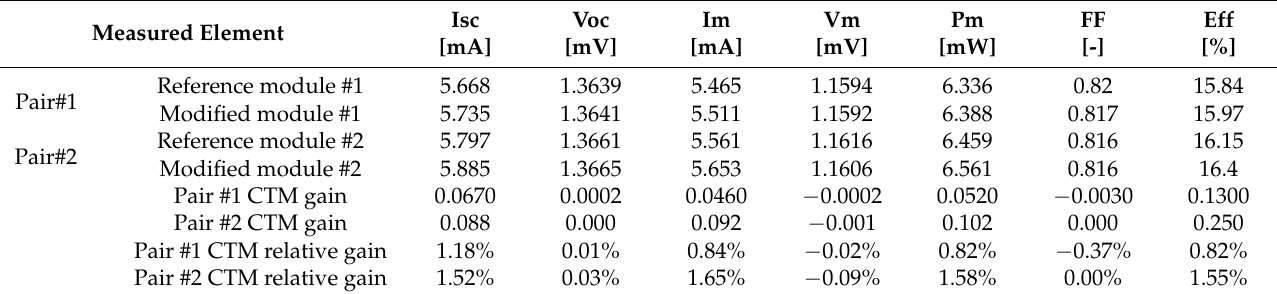
Figure 16. Photo of minimodules used for proof of concept. ( Left )—reference, ( right )—modified. Table 1. I-V characteristics of minimodules prepared as a proof of